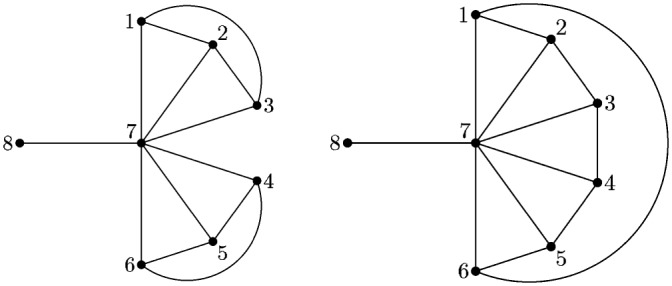
The “bat” graph G and the “umbrella” graph G′ [19].